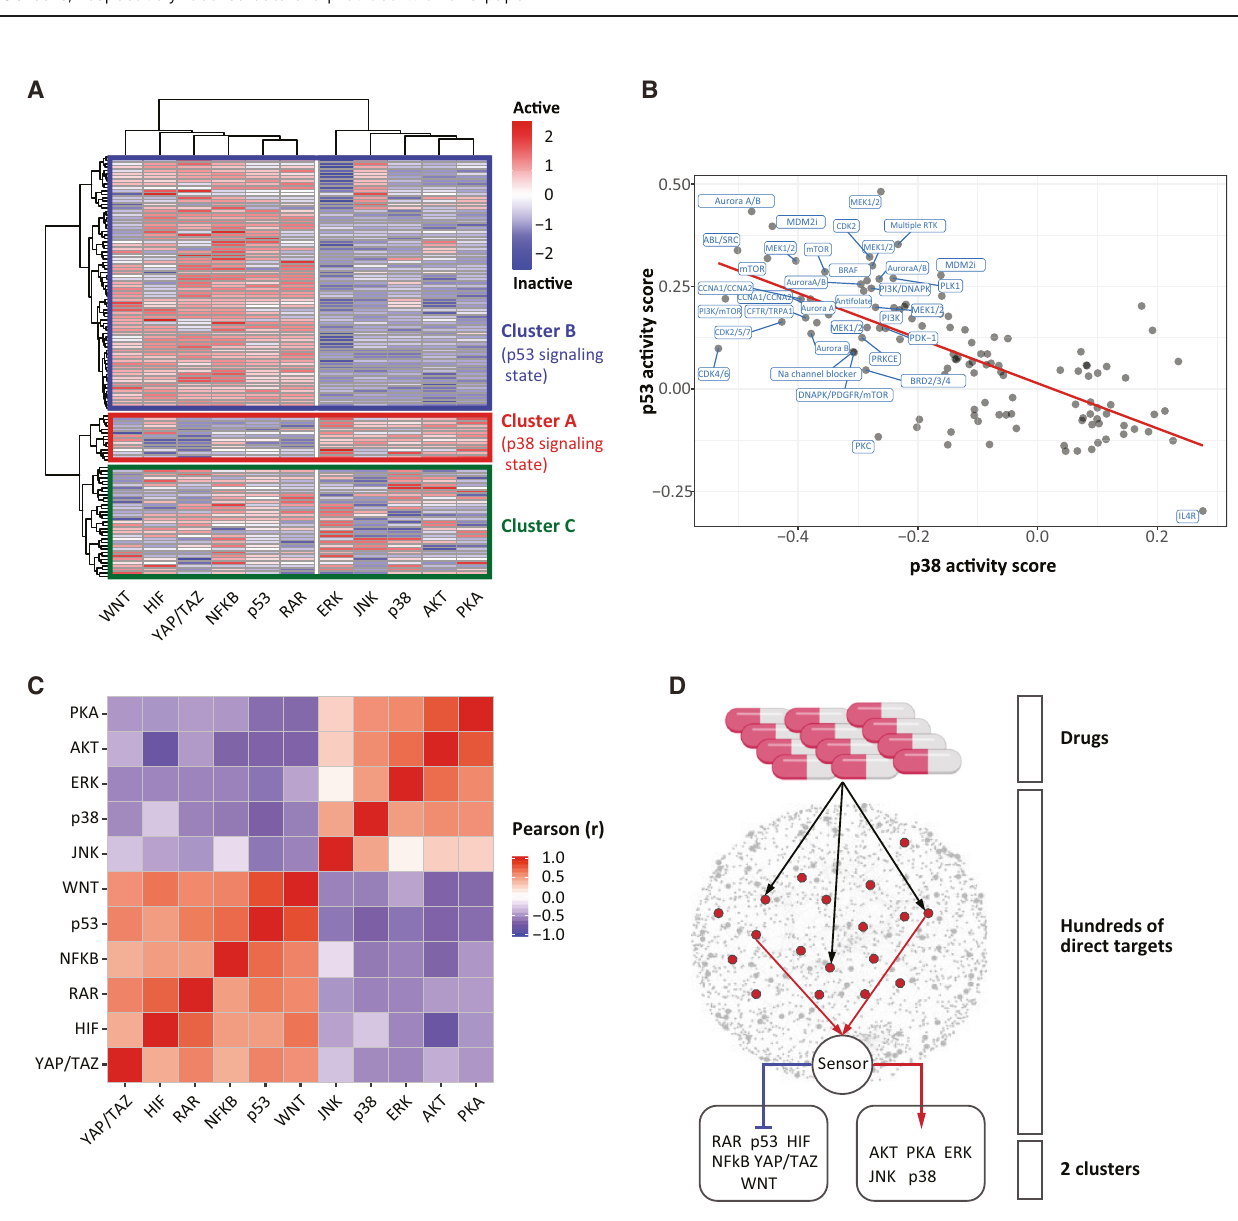
Fig. 2 Generating the A375 “ Signalome ” reporter cell line. A Illustration of the 12 clones that were used to generate the A375 Signalome cell line. A375 cells were fi rst infected with iRFP-H2A to mark the cell nucleus. Then, 12 clones were generated with 12 visual barcodes. Lastly, a different live reporter was added to each of the clones. Transcription activating reporters are represented by gold while translocation reporters are represented in red. Binding partners in the nucleus are represented in purple. B Relative number of cells from each clone in a DMSO control wells over time. C Scatter plot showing the correlation between the reporter activity scores, for all 12 clones when grown separately or as part of the Signalome cell line, in response to 75 drugs. D – F Reporter activity plots of the A375 signalome cell line in response to DMSO, vemurafenib (1 µ M) or trametinib (0.125 µ M) over time. Blue and red backgrounds represent activation or inhibition scores above 0.2 or below − 0.2, respectively. The average cell count per reporter in ( D – F ) is: 656, 545, and 530 cells, respectively. Source data are provided with this paper.